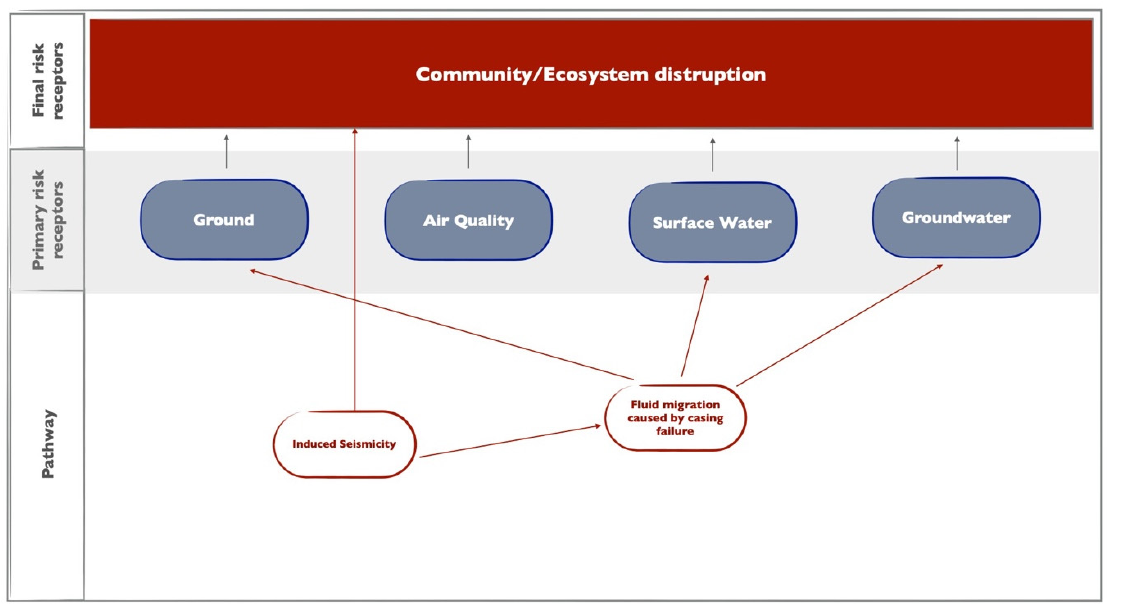
Figure 11. Risk pathways in Phase 4: Post-abandonment. White and red circles identify events related to incidents and/or extreme events.